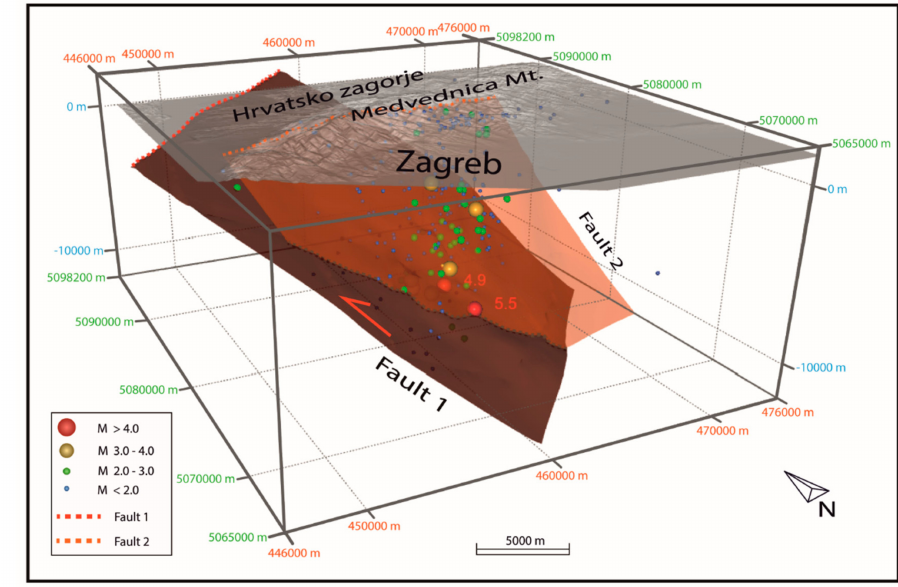
Figure 13. Preliminary structural 3D model of the Zagreb 2020 earthquake sequence. Coordinates are shown in HTRS96 / TM coordinate system, and the elevation is in meters (no vertical exaggeration). Fault 1 is interpreted as a primary thrust fault, and Fault 2 is interpreted as a secondary (reverse?)